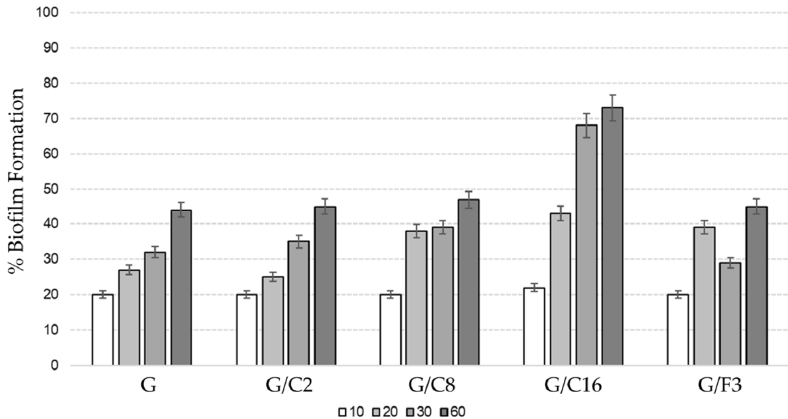
Figure 16. Percentage of microbial biofilm formation observed (with direct DAPI count) on the surfaces analyzed in this study. Different bars color identified different experimental time (10, 20, 30 and 60 days). and 60 days).